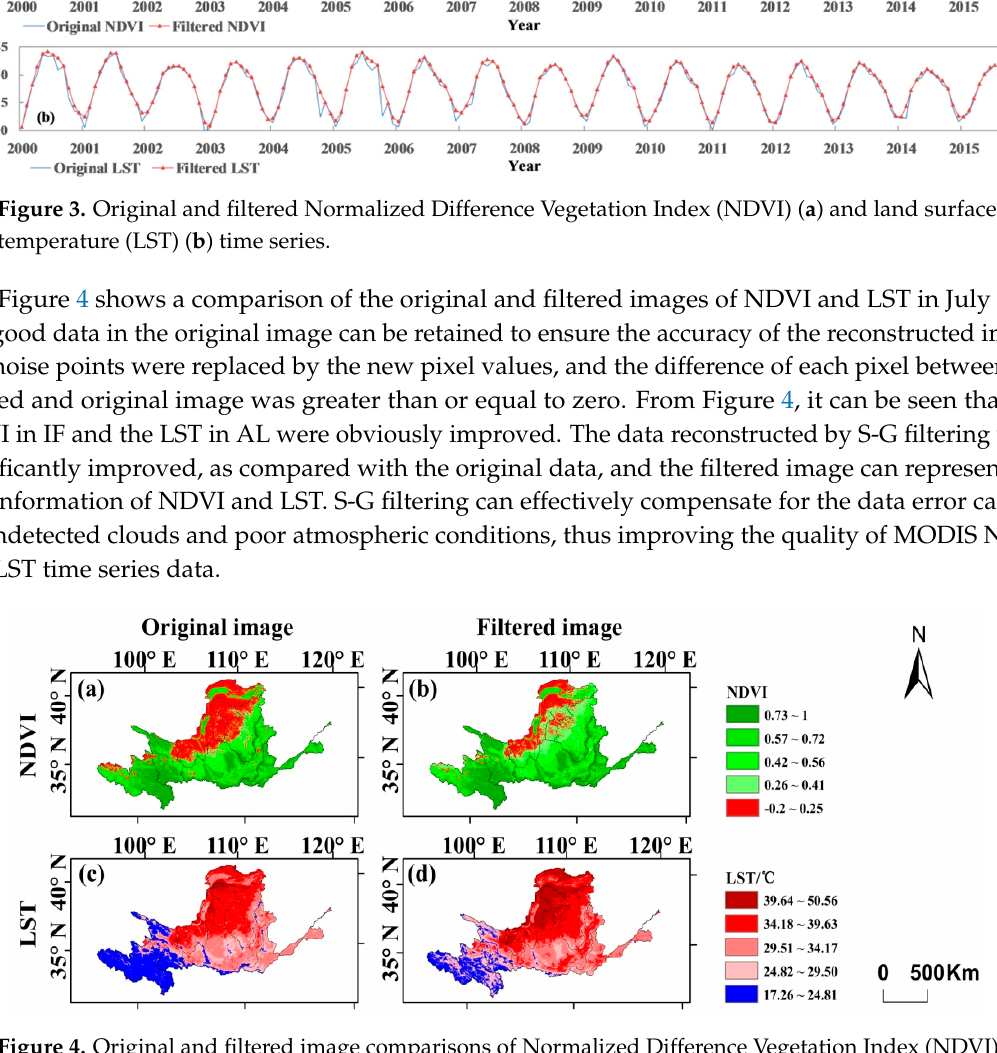
Figure 4. Original and filtered image comparisons of Normalized Difference Vegetation Index (NDVI) and land surface temperature (LST) in July 2010: ( a ) Original NDVI image; ( b ) Filtered NDVI image; ( c ) Original LST image; and ( d ) Filtered LST image.